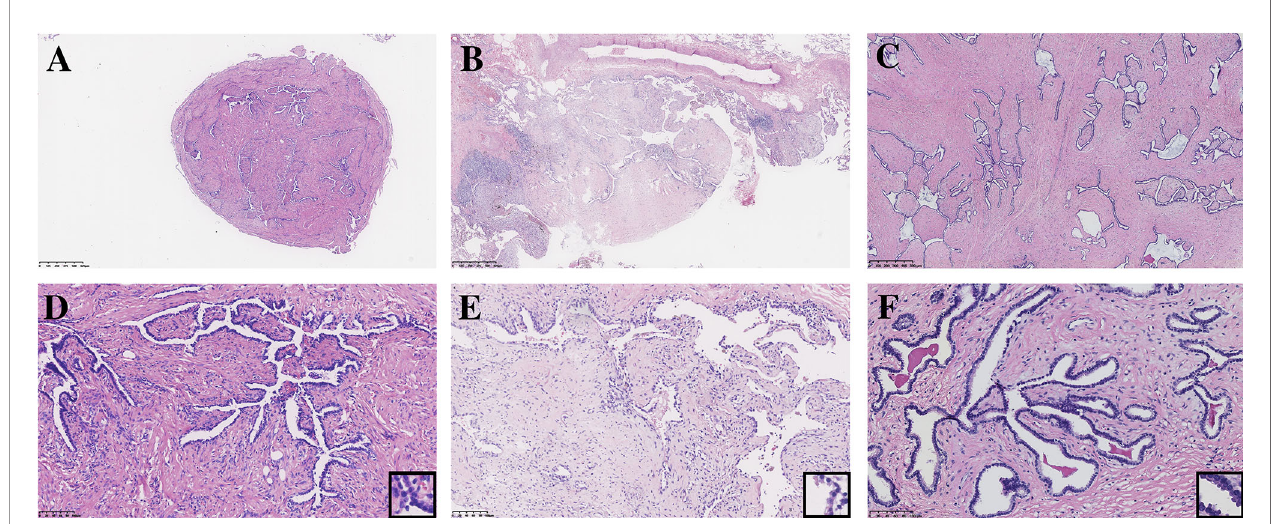
FIGURE 2 | Typical morphology of three PAFs [H.E. staining, (A – C) x40, (D – F) x200, inset x400]. Focal fat vacuoles (D) and intraglandular eosinophilic fl uid (F) were